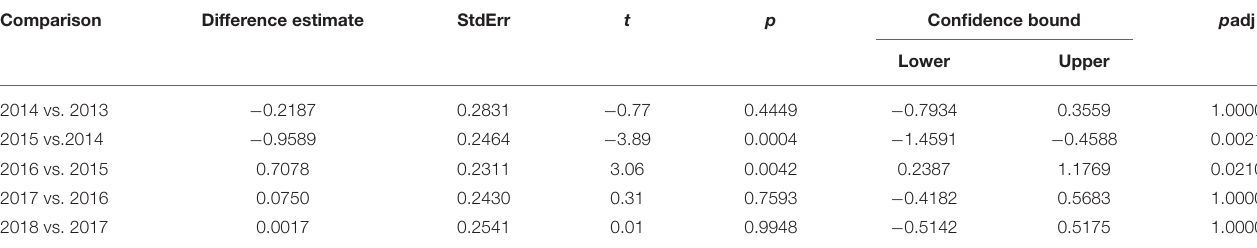
TABLE 2 | Pairwise comparison of the mean TF between 2013 and 2018, Bonferroni adjusted. Comparison Difference estimate StdErr Confidence bound